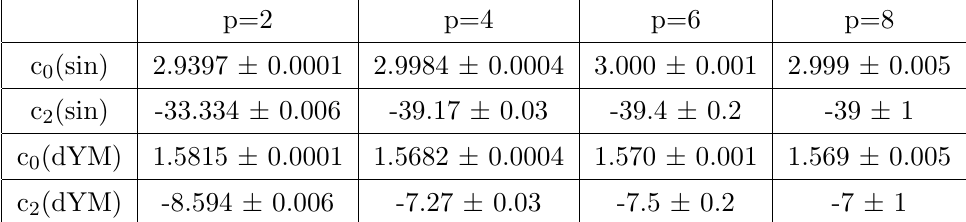
Table 5 . c 0 and c 2 for even power polynomial (cid:12)ts of order p for T 3 = T 1 for noised ( law data and